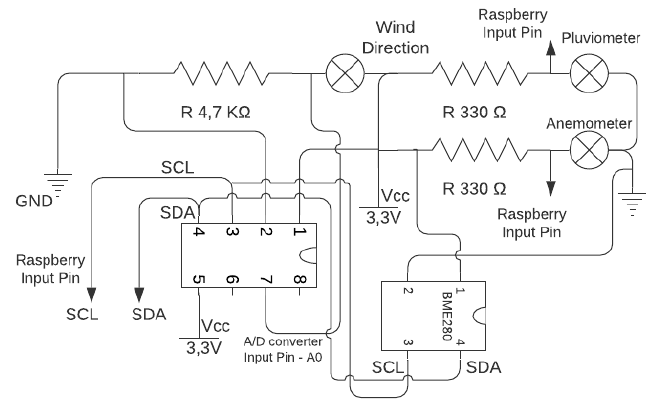
Figure 5. Signal conditioning circuit diagram.